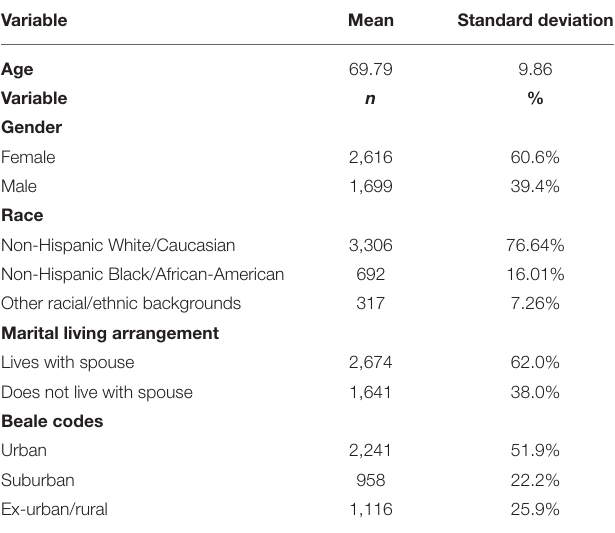
TABLE 1 | Demographic variables ( N =